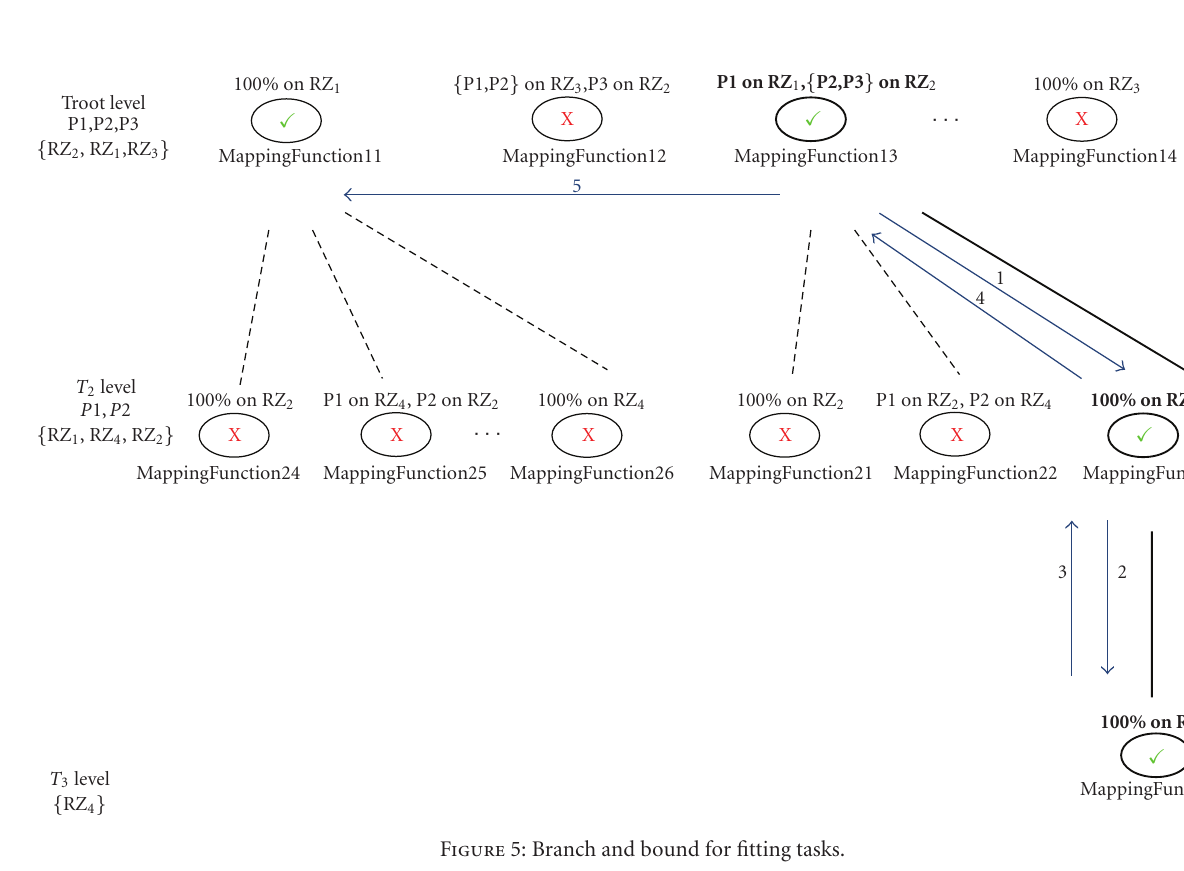
Figure 4: Branch and Bound for partitioning/fitting of RZs.